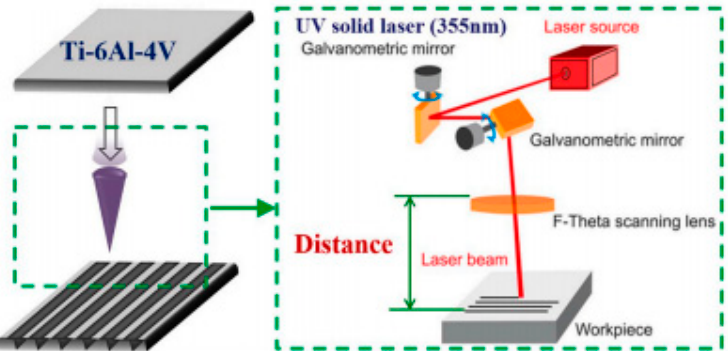
Figure 2. Schematic representation of laser processing of microgroove on Ti–6Al–4V [52]. Reprinted from [52]. Copyright from Elsevier from [52]. Copyright from Elsevier 2020.